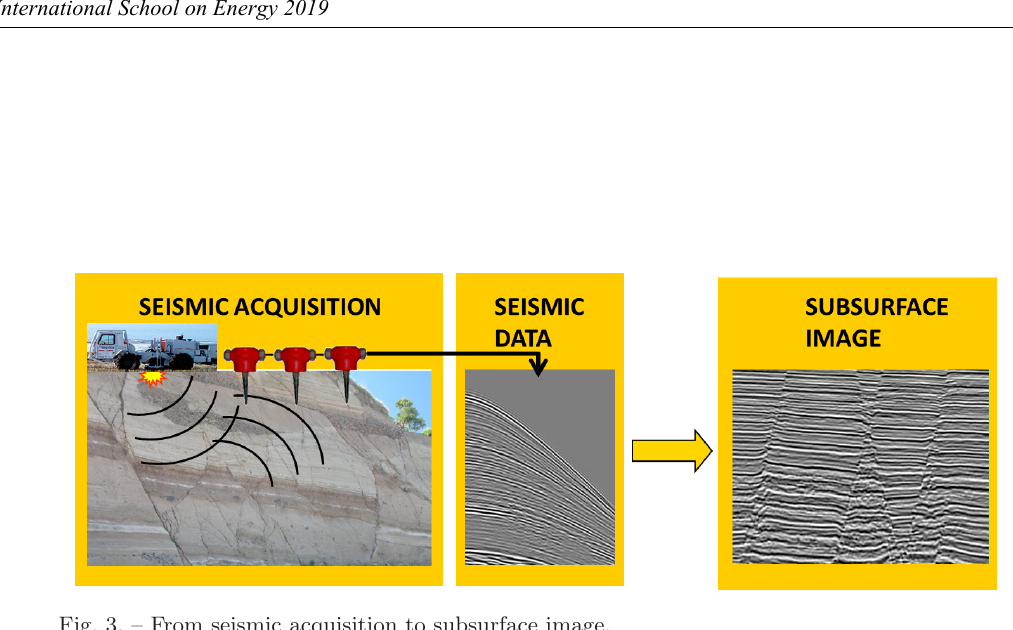
Fig. 3. – From seismic acquisition to subsurface